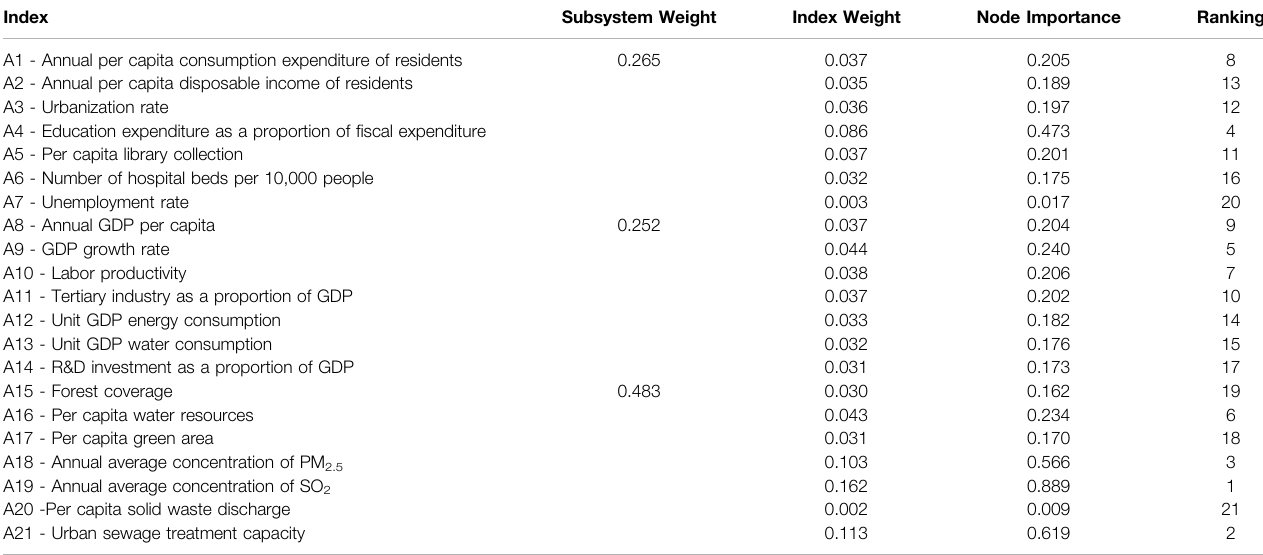
TABLE 3 | Node importance and index